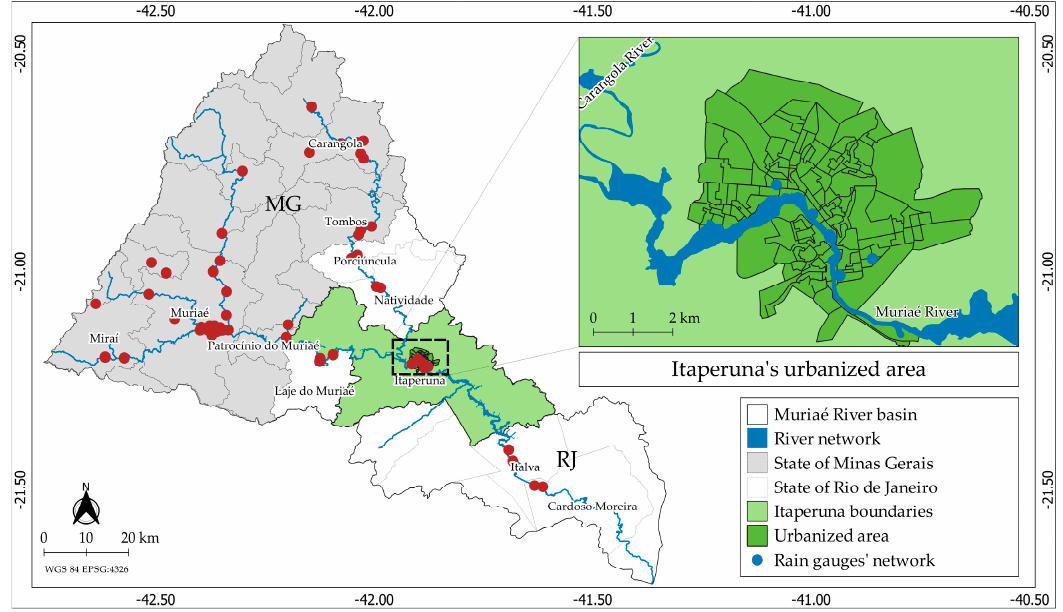
Figure 1. The Muriaé River basin, the municipality of Itaperuna, and the rain gauges’ locations. Figure 1. The Muria é River basin, the municipality of Itaperuna, and the rain gauges’